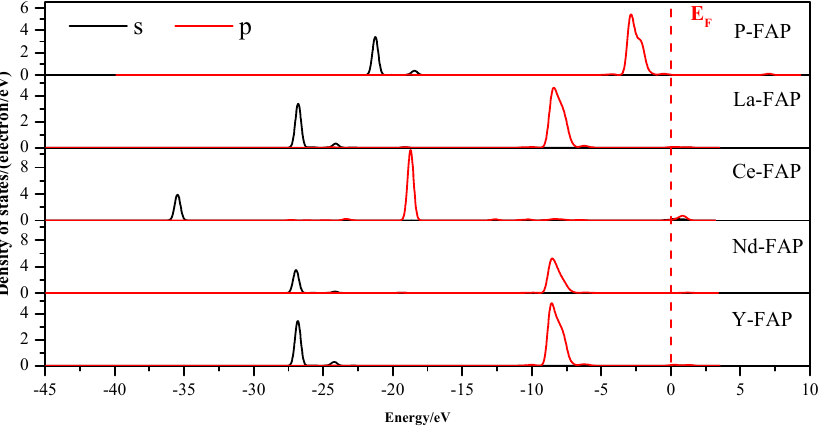
Figure 8. PDOS of a single F atom adjacent to the rare earth atom in REE-FAP crystals.